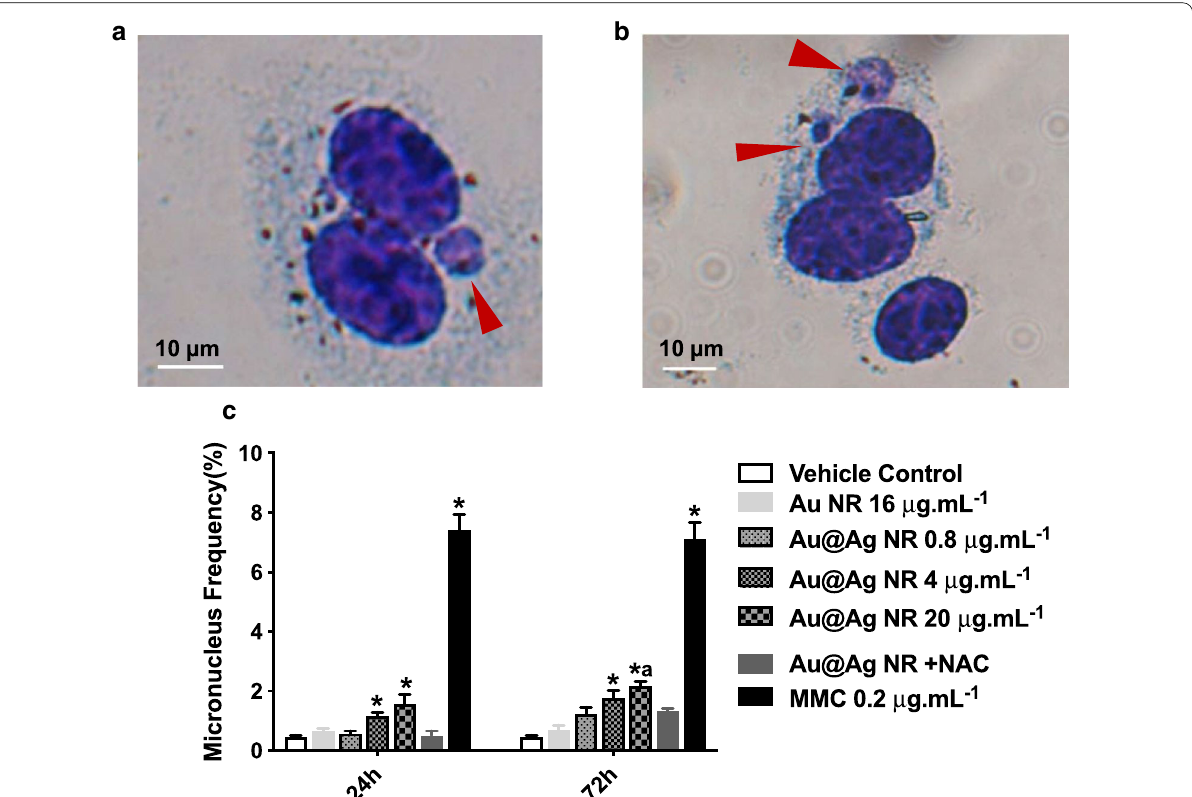
Fig. 4 Chromosome damage induced by Au@Ag NR. HepaGR cells were exposed to Au@Ag NR at different concentrations from 0.8 μg mL − 1 to 20 μg mL − 1 for 24 h and 72 h. a , b Representative images of micronucleus (red arrow); c micronucleus frequency (%). * P < 0.05 versus vehicle control; a P < 0.05 versus Au NR. 0.2 μg mL − 1 mitomycin C was employed as a positive